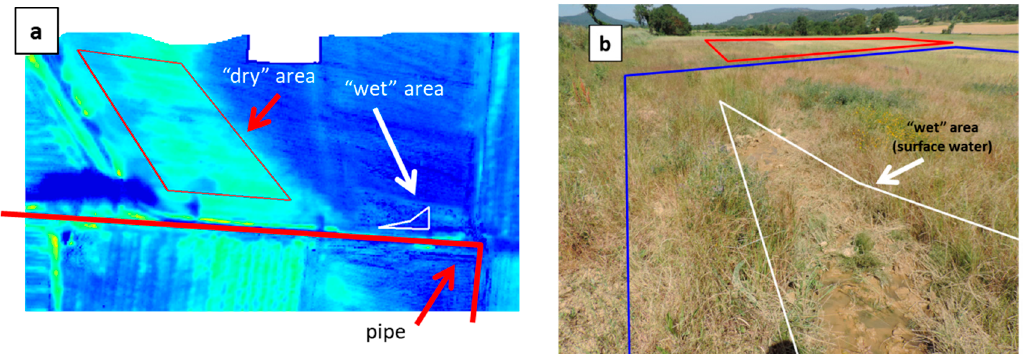
Figure 5. ( a ) Close ‐ up of the top right part of the water index map in Figure 4c, a “dry” area chosen for reference and a “wet” area showing surface water. ( b ) Picture showing the “wet” area in the foreground and the “dry” area (red polygon) in the background (picture taken on 12 June 2017). The blue polygon in Figure 5b refers to a soil depression where it is believed that water spurting from the soil in the “wet” area may runoff, hence leading to high WI values.